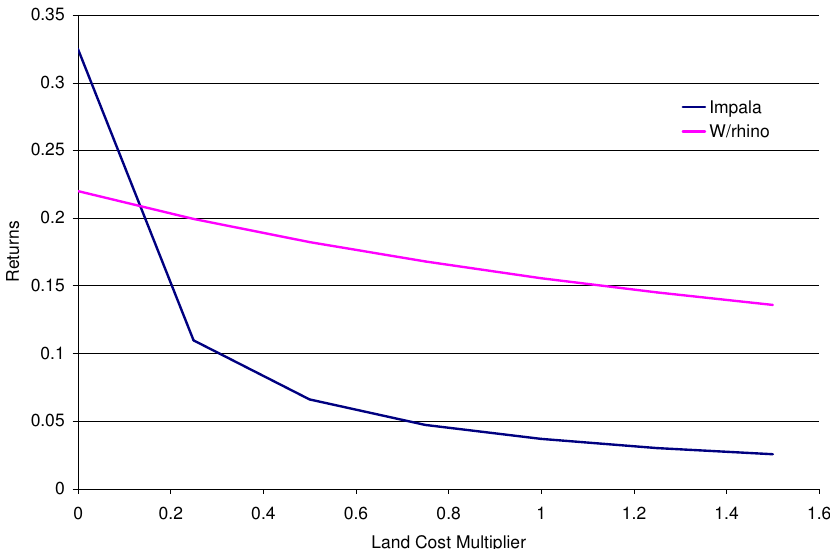
Figure 5: The effect of land costs on the returns from impala and white rhino.